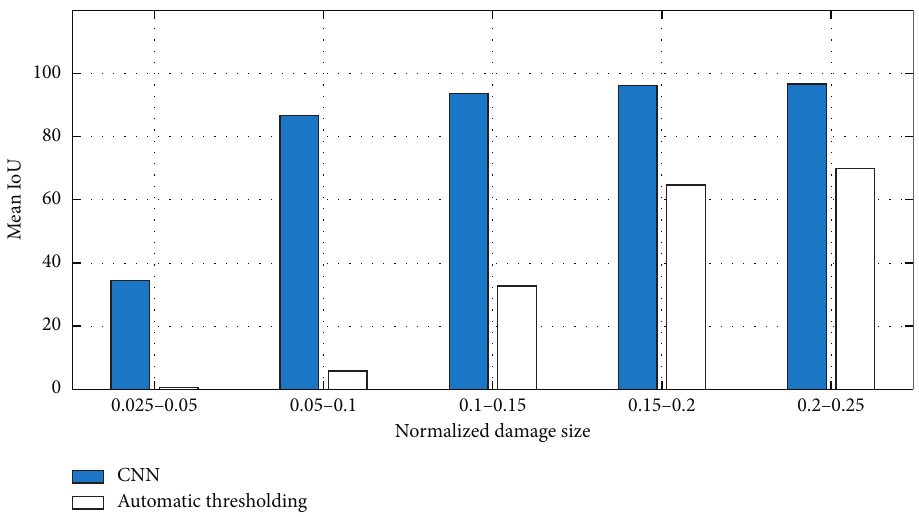
Figure 10: Performance of the damage-assessment